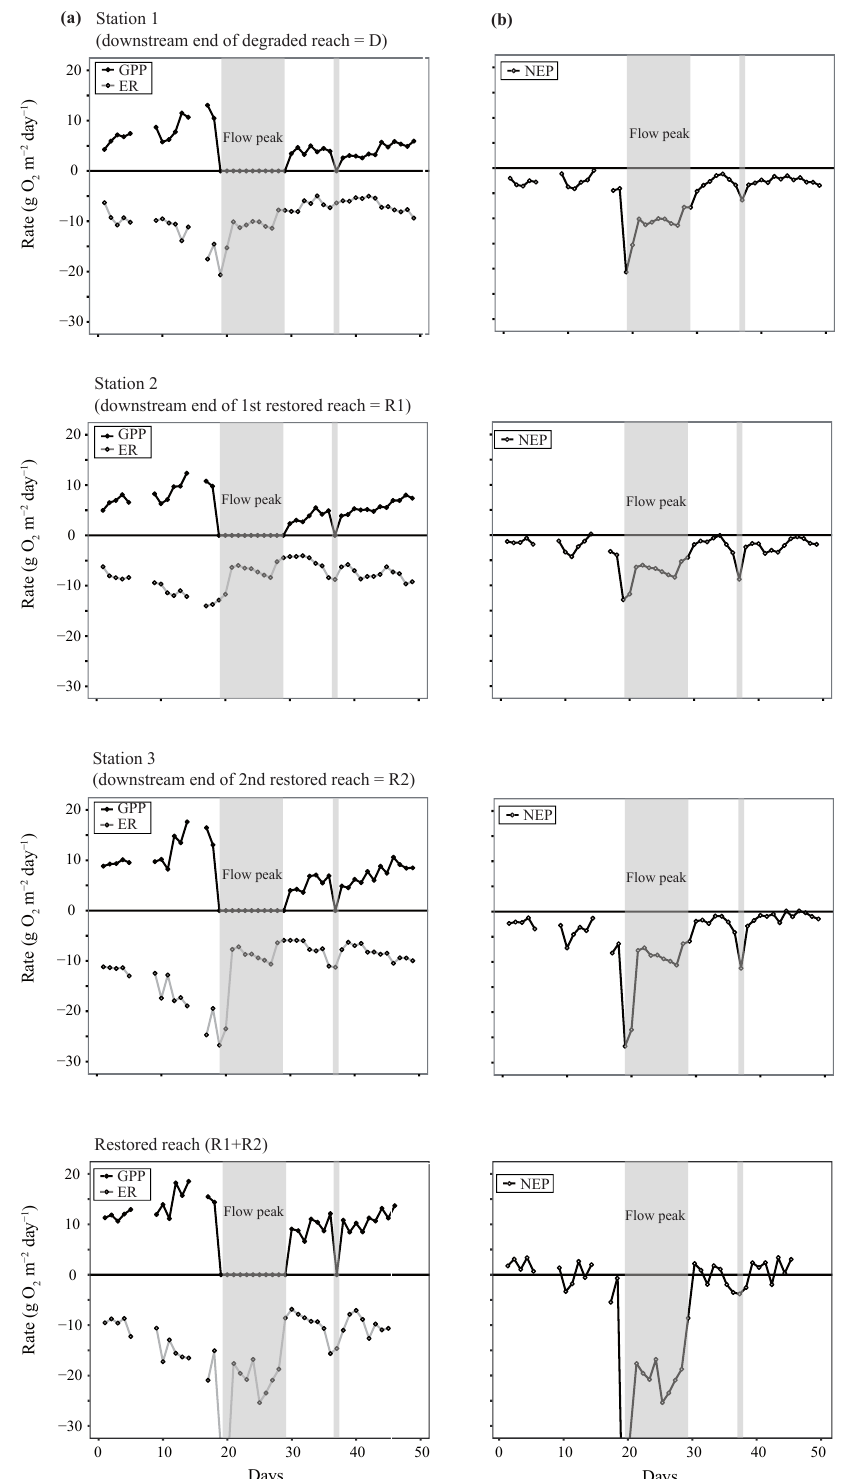
Figure 6. Daily rates of (a) gross primary production (GPP: positive values, black line) and ecosystem respiration (ER: negative values, grey lines) and (b) net ecosystem production (NEP) measured at the downstream ends of the investigated reaches (degraded = D; first restored = R1; second restored = R2) and for the combined reaches R1 + R2 of the river Ruhr in summer 2014. Vertical grey bars indicate peak flow